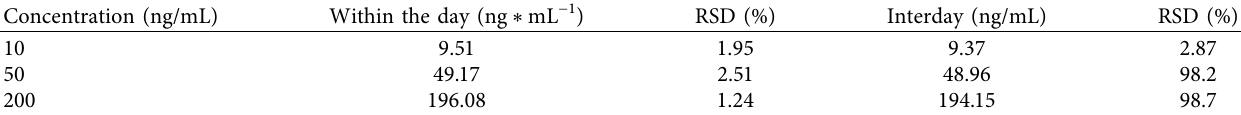
Table 4: Extraction precision of troxerutin aglycone in mouse brain tissue. Concentration